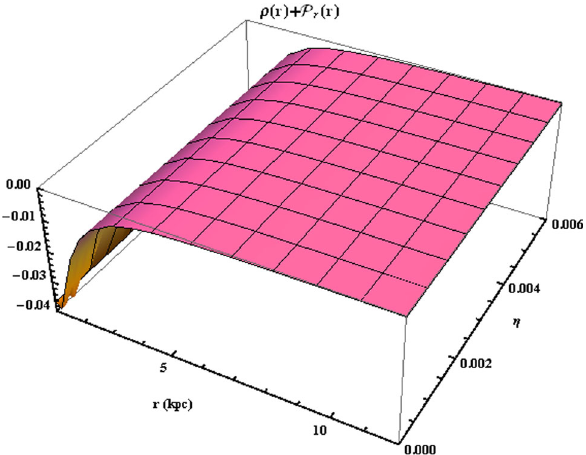
Fig. 8 ρ( r ) + P r ( r ) is plotted with respect to the radial coordinate r correspondingtotheparameters ρ 0 = 0 . 004 kpc − 2 , alpha = 0 . 5 , β = 0 . 8 , r th = 1 kpc ,τ = 2 . 5 and r 0 = 2 kpc